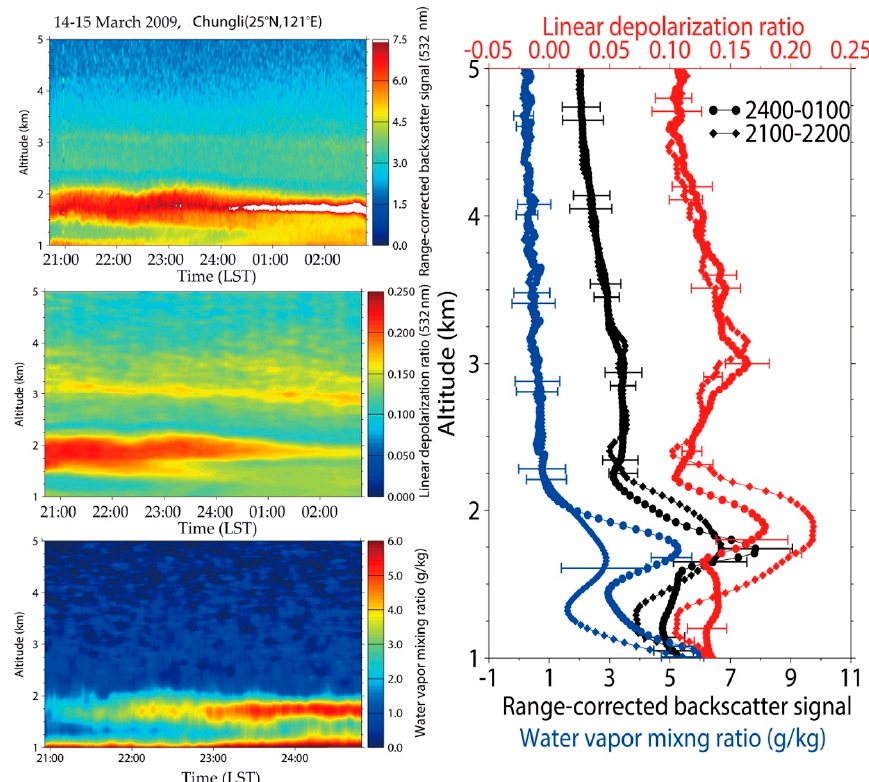
Figure 2. Left panel: vertical structure of the dust aerosols and clouds observed by ground-based PR lidar in Chungli, Taiwan beginning at 20:45 LST on 14 March 2009; Right panel: mean profiles of range-corrected lidar backscatter signal (black), linear depolarization ratio (red) and water vapor mixing ratio (blue) from the PR lidar observation. Errors are estimated based on Chiang et al. [47]. Remote Sens. 2018 , 10 , x FOR PEER REVIEW To locate the source region and the transport path of the dust aerosols, 48 h backward trajectories using the NOAA HYSPLIT model were analyzed for the duration of the dust episode with the PR lidar site selected as the starting point. We calculated approximately 500 single backward trajectories over the altitude range of 100 to 3500 m for the period from 12:00 to 24:00 LST on 14 March 2009. The time interval and altitude resolution of the backward trajectories were 1 h and 100 m, respectively. Subsequently, the PDF of all of the trajectories at each 0.5° × 0.5° grid was calculated. Figure 3 shows that most of the backward trajectories were traced to the Gobi Desert, which is the second largest dust source in East Asia. Therefore, the dust aerosols were long-range transported from the Gobi Desert to Taiwan Island across Southeast China. CALIPSO measurements confirm the trajectory analysis that the dust event affected vast regions of China, as shown in Figure 4. According to the HYSPLIT backward trajectory analysis, the average travel time of the air masses from the Gobi Desert to the PR lidar site was approximately 43 h over a distance of ~2000 km.